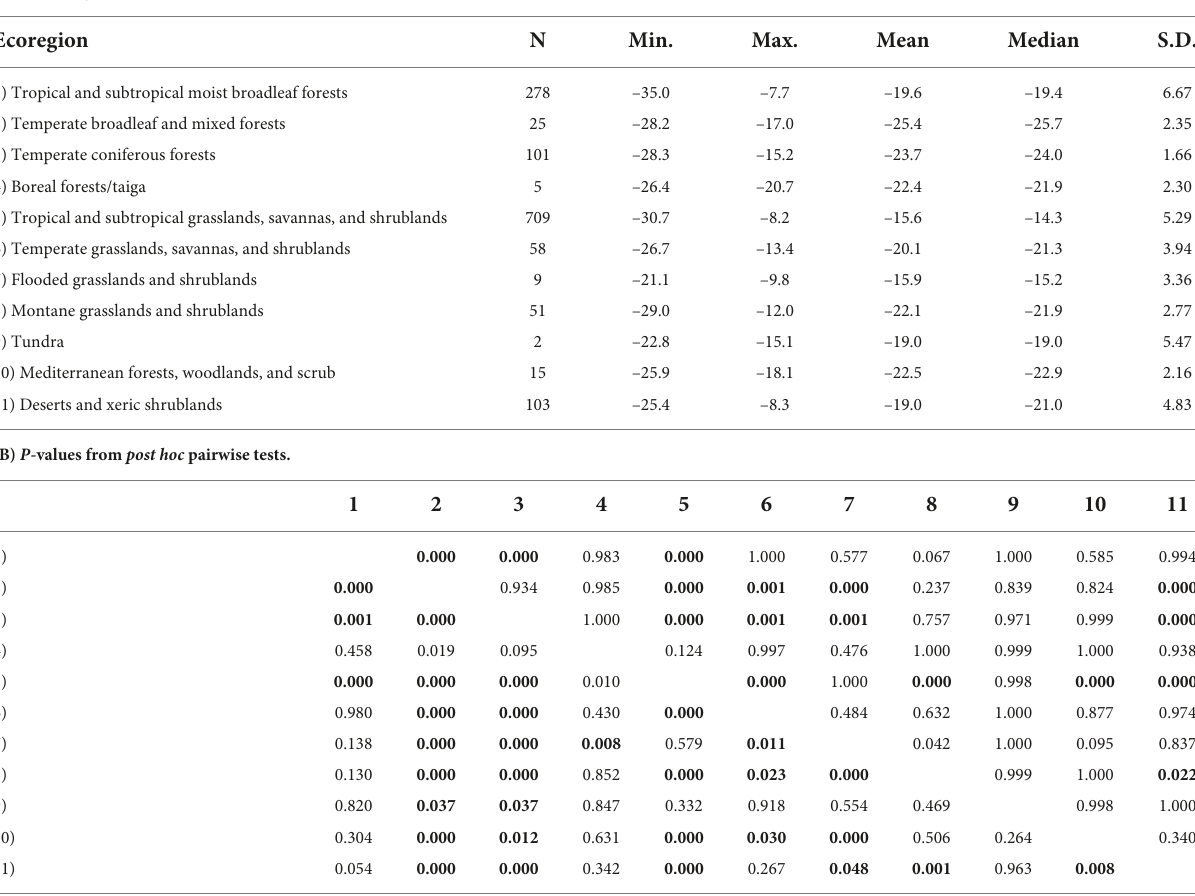
TABLE 4 Comparison of δ 13 C diet values of artiodactyls among 11 ecoregions, each found on multiple